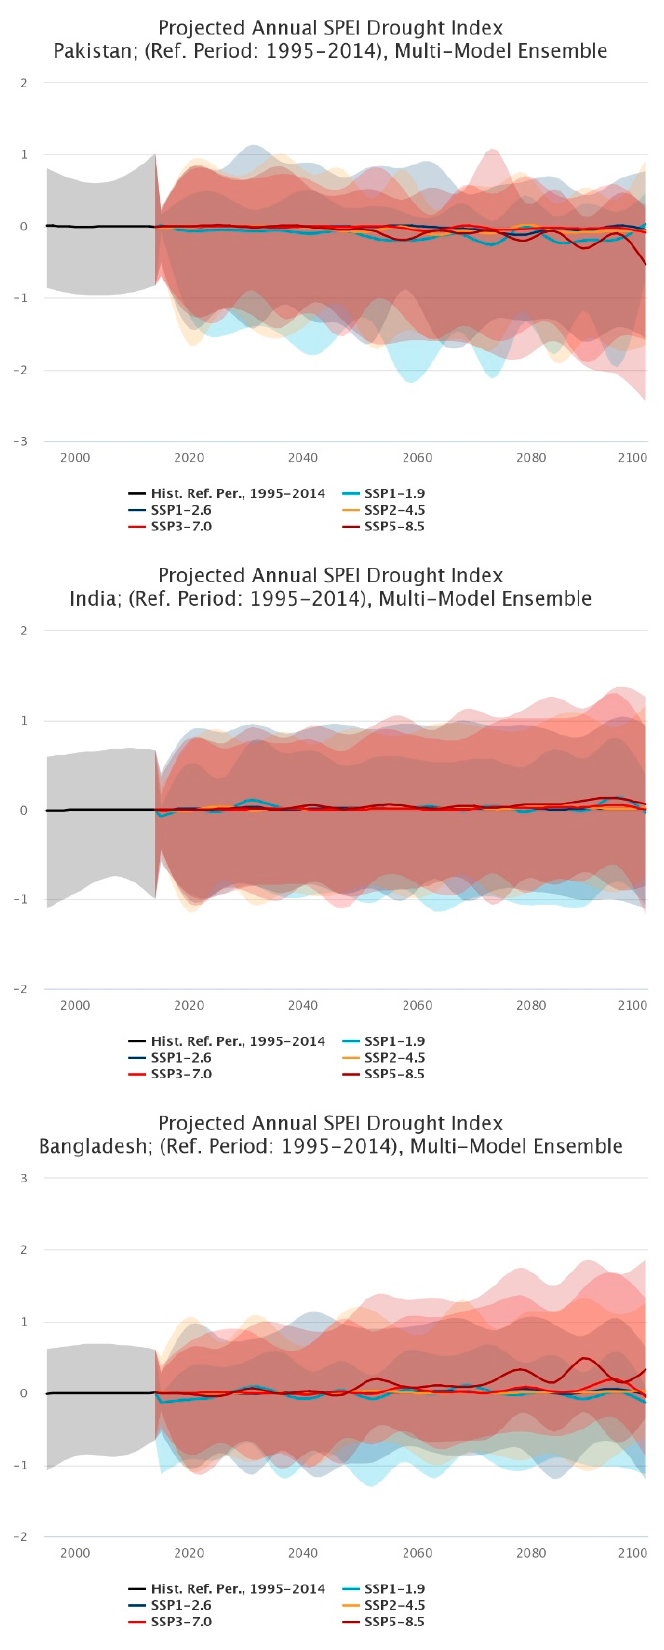
Figure 11. Projected Annual SPEI Drought Index (Reference Period: 1995–2014) sequential analysis trends for the 21st century [49].